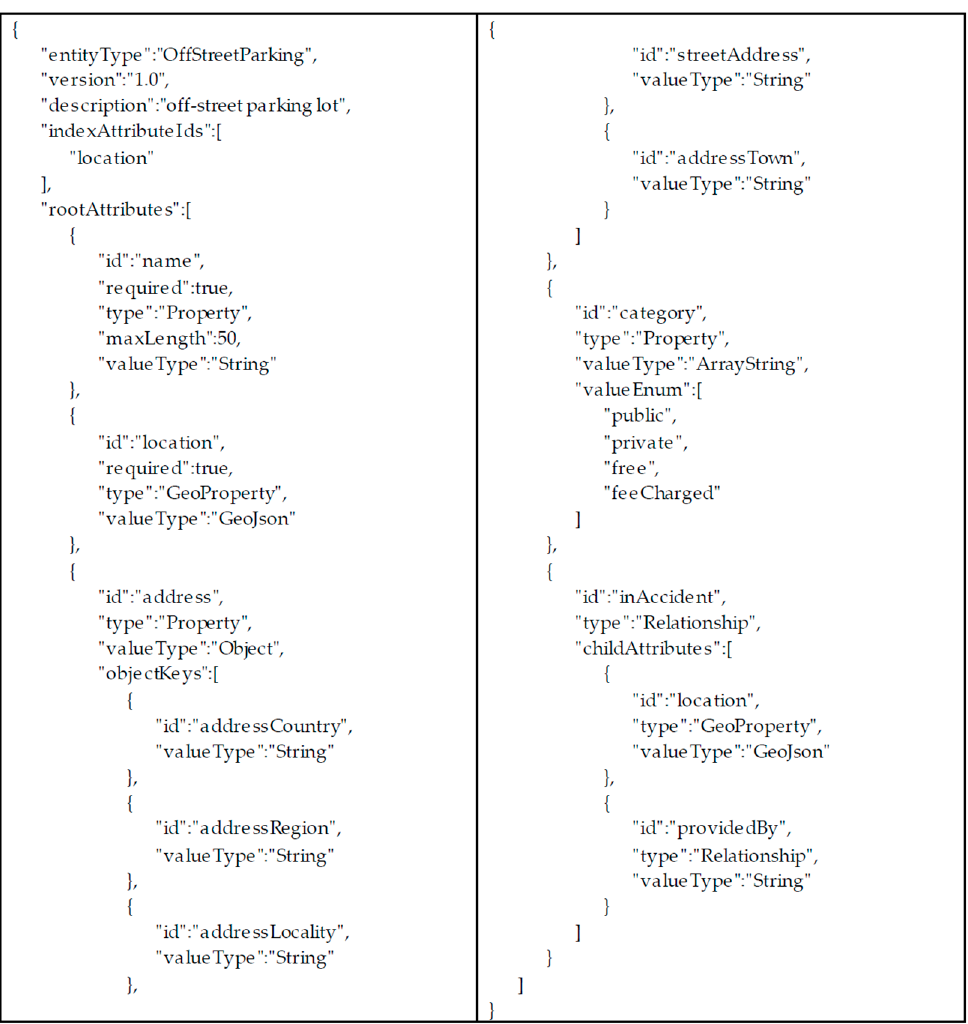
Figure 4. Schema definition example of an off-street parking lot.